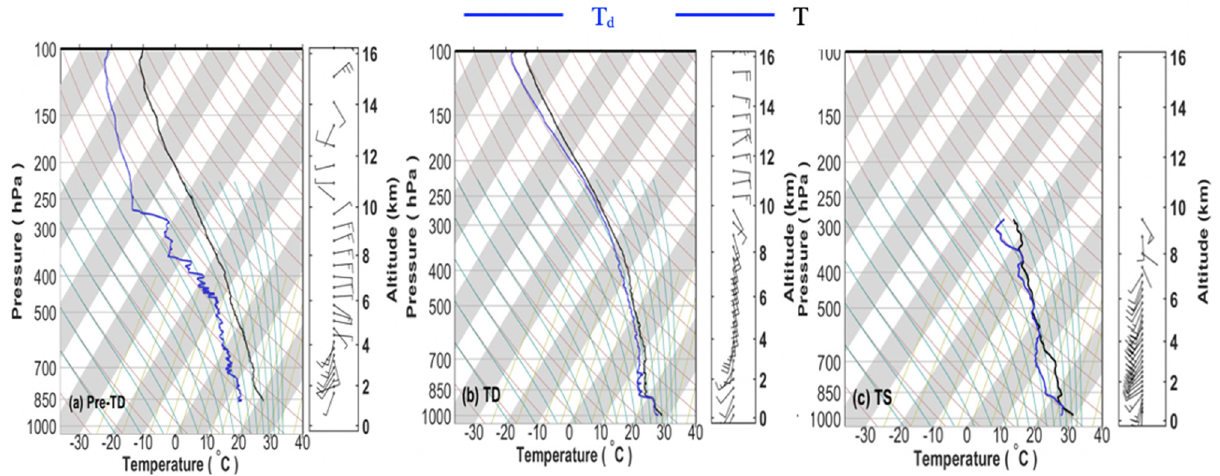
Figure 7. The skew T − log P diagrams from two-way rawinsonde measurements at the stages of ( a ) pre-TD and ( b ) TD and from dropsonde measurements at the stage of ( c ) TS for Typhoon Sinlaku (2020).